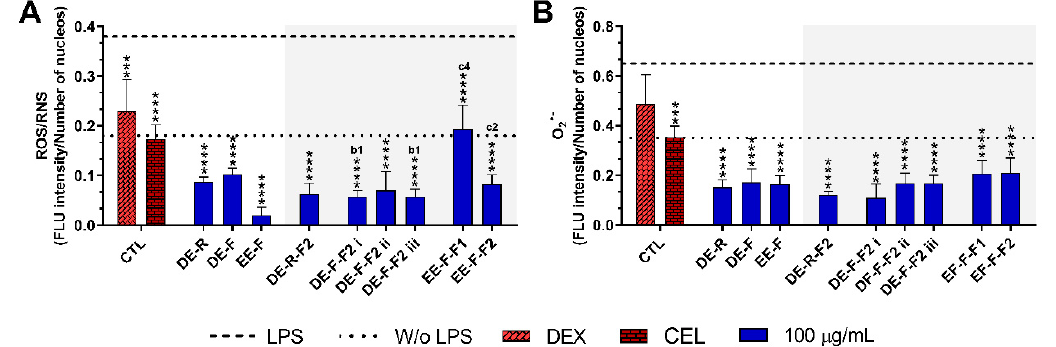
Figure 6. Fluorescence intensity of intracellular ROS/RNS ( A ) and O 2 •− ( B ) production in LPS-stimulated human monocyte-derived macrophages (hMDMs) in the absence or presence of E. purpurea extracts, fractions, and clinically used anti-inflammatory drugs (dexamethasone (DEX) and celecoxib (CEL), 10 µ M) cultured for 24 h. Fluorescence intensity was measured using ImageJ software. The dotted line represents the basal levels of ROS/RNS and O 2 •− in non-stimulated hMDM (negative control) and the dashed line corresponds to the amounts of ROS/RNS and O 2 •− produced by LPS-stimulated hMDM (positive control). Statistically significant differences are *** ( p < 0.0002) and **** ( p < 0.0001) in comparison to the positive control (LPS-stimulated hMDM without treatment) for each tested E. purpurea extract, fraction, DEX, and CEL, as well as 1 ( p < 0.0453), 2 ( p < 0.0023), and 4 ( p < 0.0001) in comparison with b (DE-F vs. DE-R-F2) and c (EE-F vs. EE-F-F) at the same concentration. CTL: control; DE: dichloromethanolic extracts; EE: ethanolic extracts; R: roots; F: flowers; F1: phenol/carboxylic acid fraction; F2: alkylamide fraction.